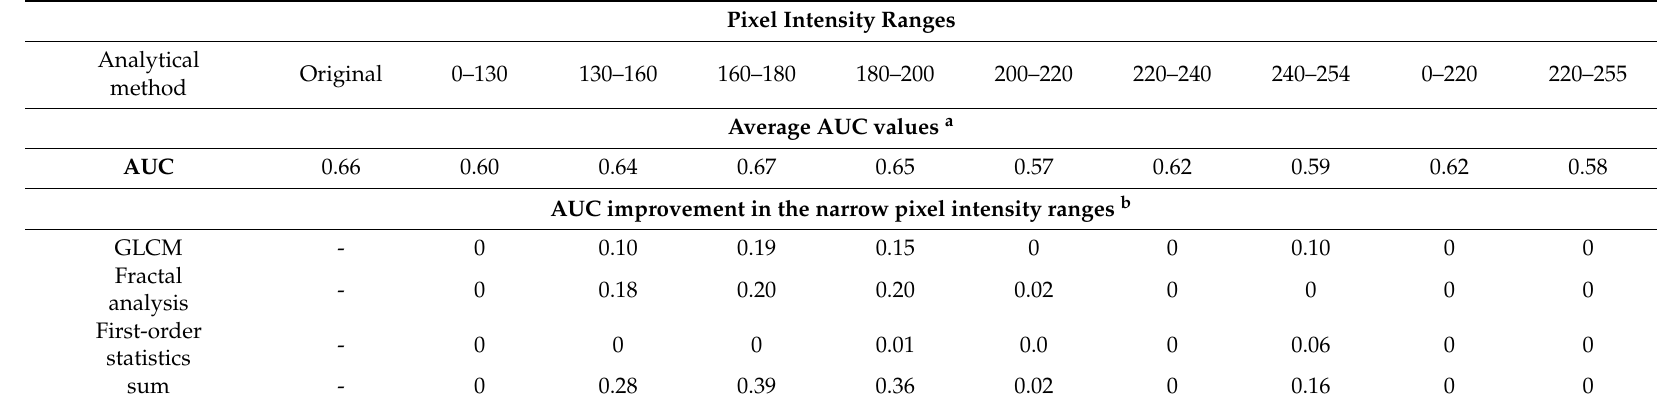
Table 2. Distribution of prognostic value among the pan cytokeratin immunostaining intensities. Pixel Intensity